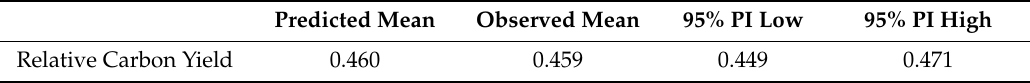
Figure 5. Fermentation products at the optimum glycerol:molasses ratio. Butyric acid is produced from the sugars present, then subsequently re-assimilated to increase the productivity of butanol. Conditions were tested in triplicate with the mean of the results presented. Error bars represent standard deviation from the mean. Table 4. Comparison of the predicted and observed relative carbon yield at the optimum ratio